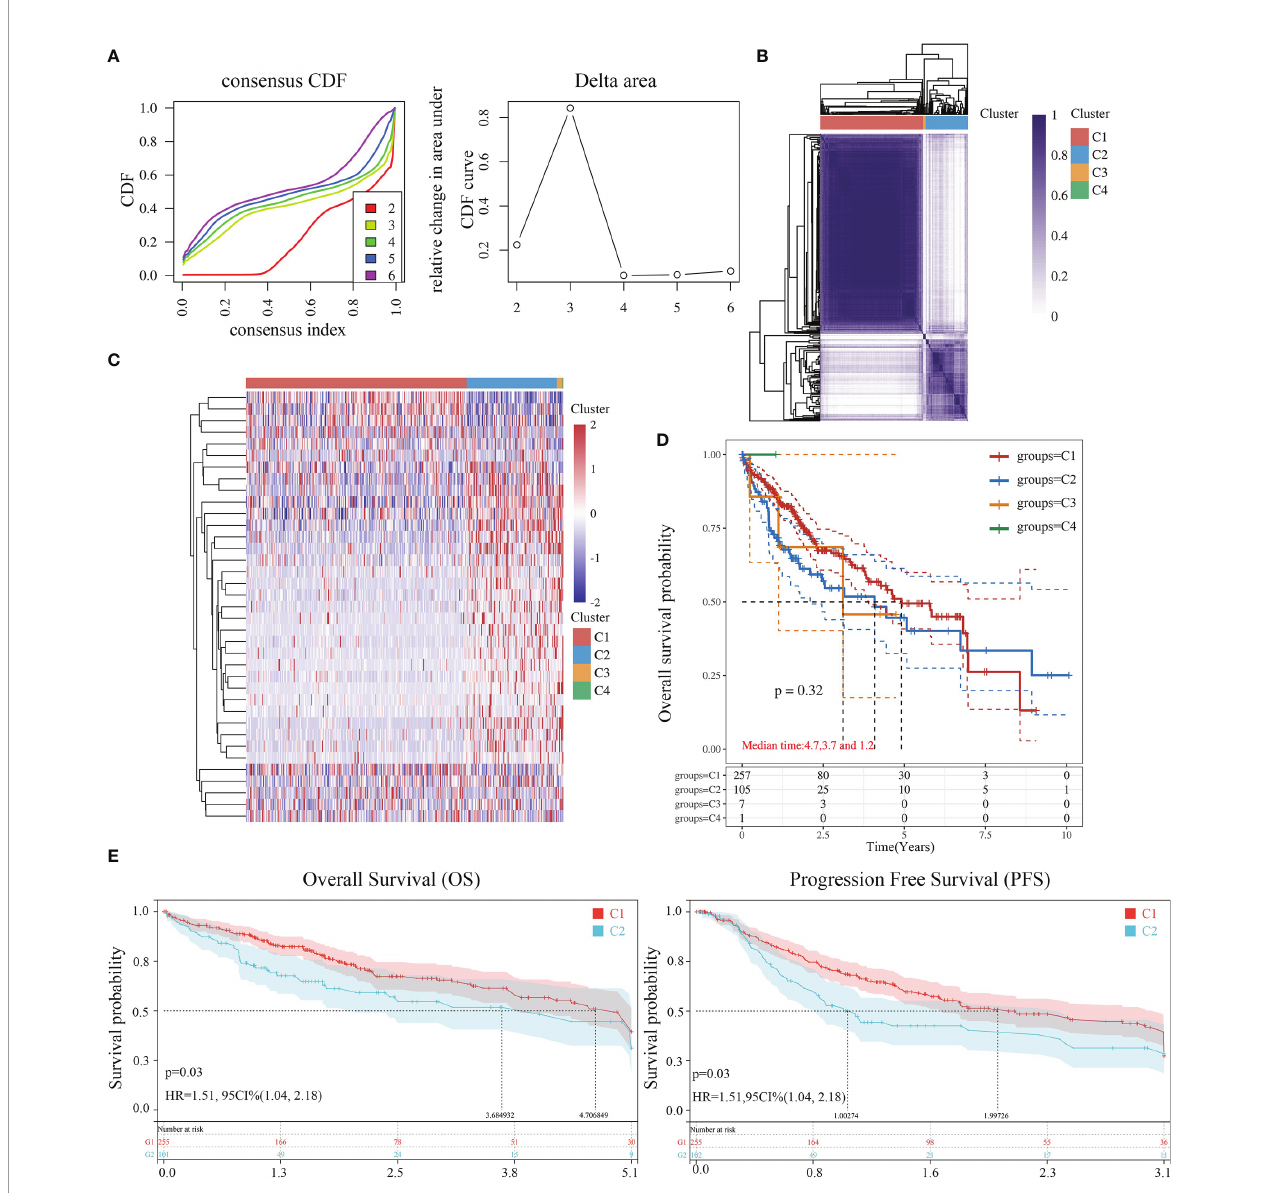
FIGURE 1 | Identi fi cation of LIHC subtypes based on NRGs using ConsensusClusterPlus. (A) CDF curve and delta area curve of consensus clustering. (B) Heat map of consensus clustering solution. Rows and columns represent samples, and the colors represent different categories. (C) Heat map of NRG expression in different subtypes: red corresponds to high expression, while blue corresponds to low expression. (D) The KM survival curve of different samples in TCGA data sets. (E) The OS (5 years) and PFS KM curves (3 years) of groups C1 and